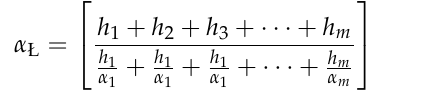
Figure 9. Change in ambient temperature during the operation of the electric machine.